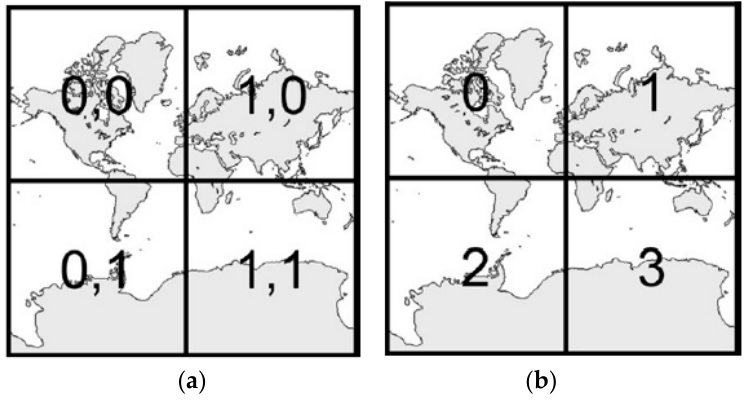
Figure 1. Scheme of Google map tiles ( a ) and Bing map tiles ( b ).